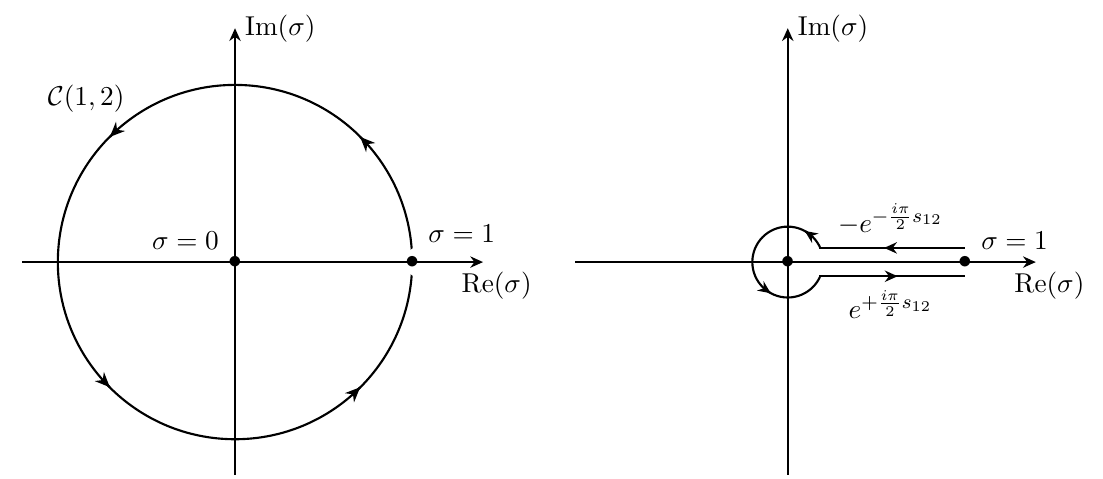
Figure 4 . As depicted in the left panel, the integration contour C (1 ; 2) in the (cid:27) 2 = e 2 (cid:25)iz 2 variable is the unit circle j (cid:27) 2 j = 1. When replacing C (1 ; 2) by the homotopy-equivalent combination of paths visualized the right panel, the multivalued part of the integrand (cid:27) s 12 = 2 depending on the sign of the small imaginary part of (cid:27) 2